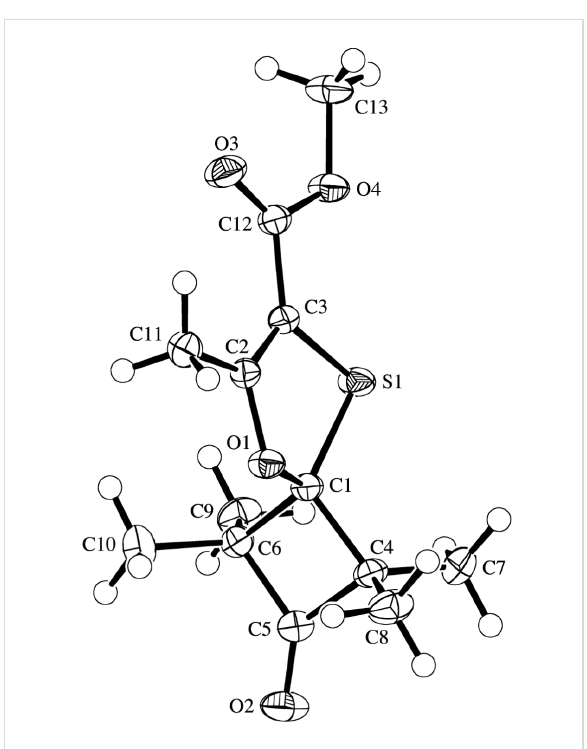
Figure 2: ORTEP plot [17] of the molecular structure of the 1,3- oxathiole 3a (50% probability ellipsoids; arbitrary numbering of atoms).